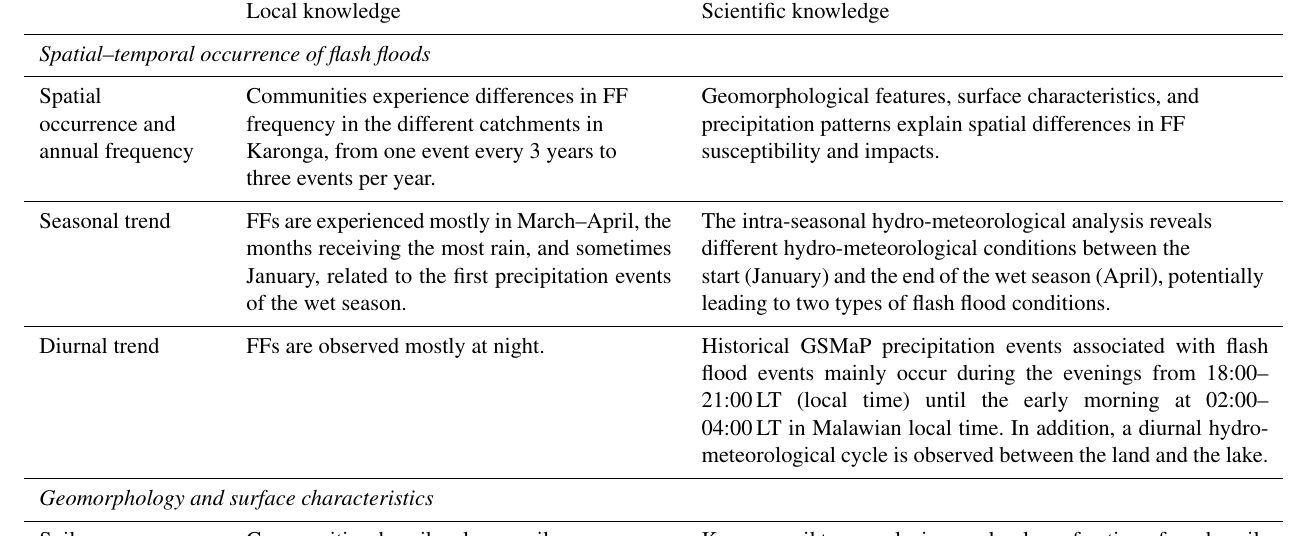
Table 3. Synthesis of the local and scientific knowledge on flash flooding in northern Malawi. FF: flash flood. LK: local knowledge. Local